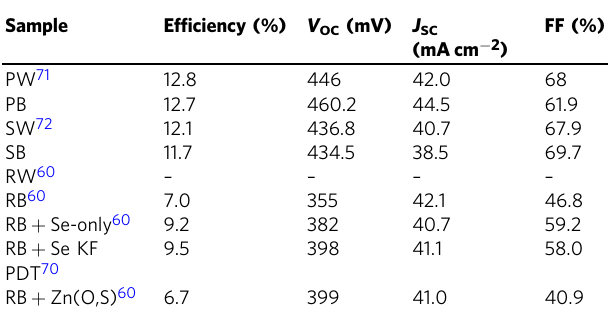
Table 2 Parameters of solar cell devices comprising CIS absorbers with various compositions subject to surface treatments.